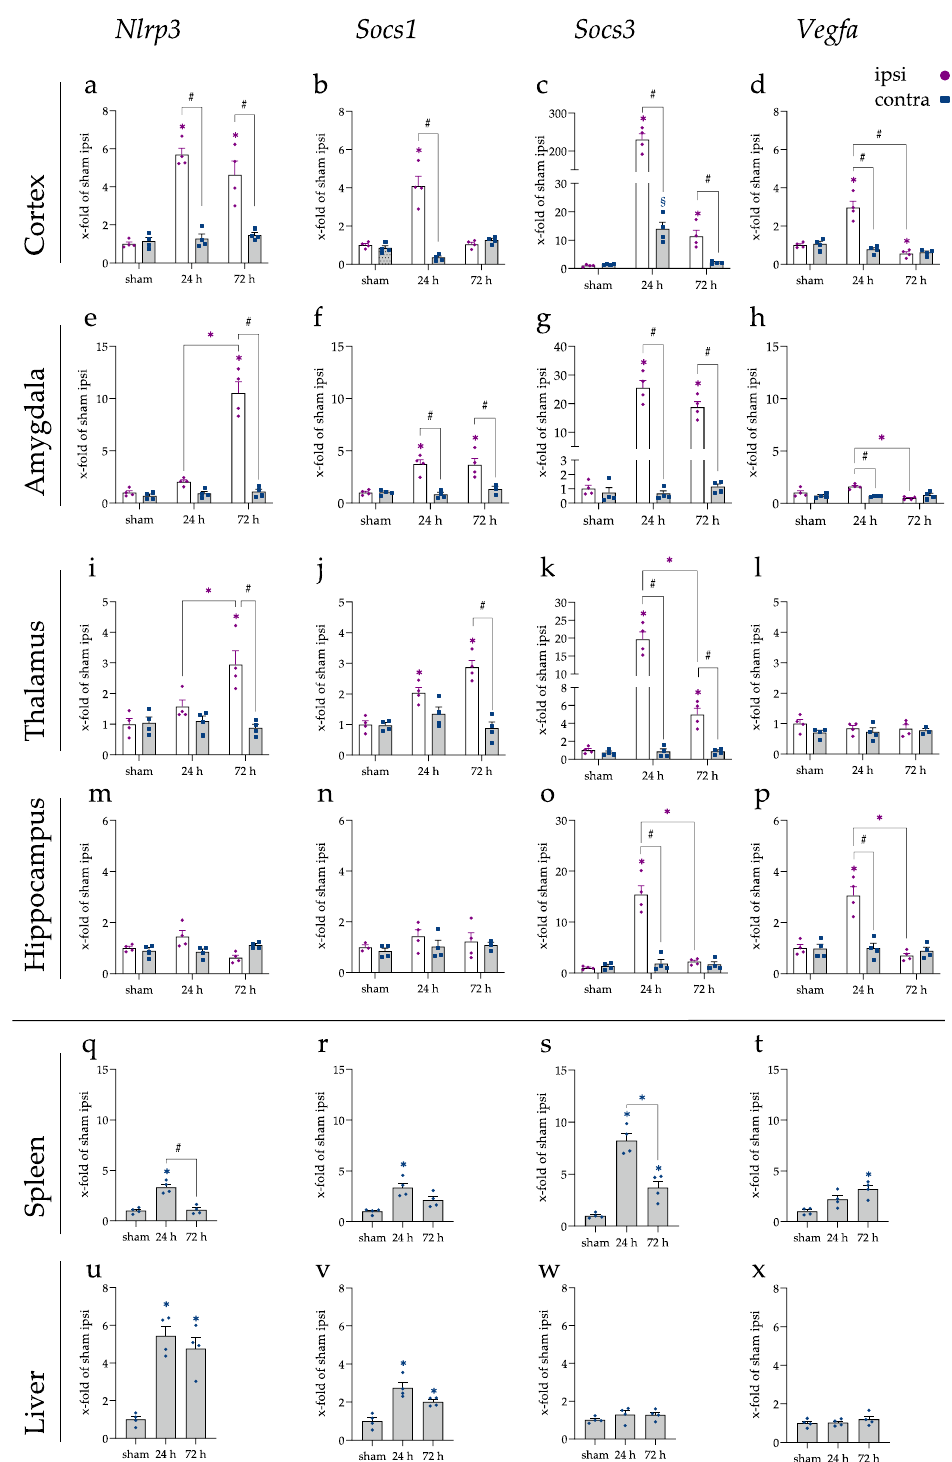
Figure 5. mRNA levels of Nlrp3, Socs1, Socs3, and Vegfa. The mRNA levels were measured in different brain parts and the peripheral organs, spleen, and liver. The results are sorted in rows for the various tissues and columns for the individual target. ( a – p ) results of different brain areas and ( q – x ) results of liver and spleen. The graphs show the individual values for ipsi (purple) and contra (blue) and the mean in bars. Data were normalized to sham ipsi group and are pictured with the x-fold expression of this group ± SEM. (*) shows a significant difference between the ipsilateral side and sham ipsi, where (§) shows a significant difference between the contralateral side and sham contra. (#) comparison as indicated.